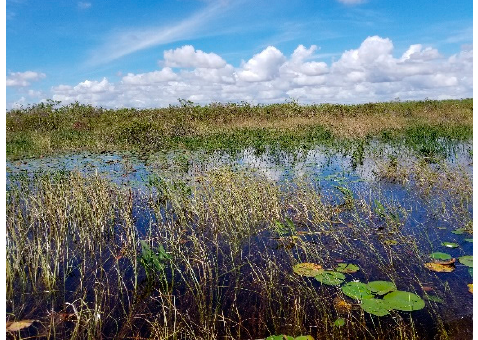
Figure 9. View of wetlands of Everglades in South Florida. nps.gov (accessed on 20 February 2021).